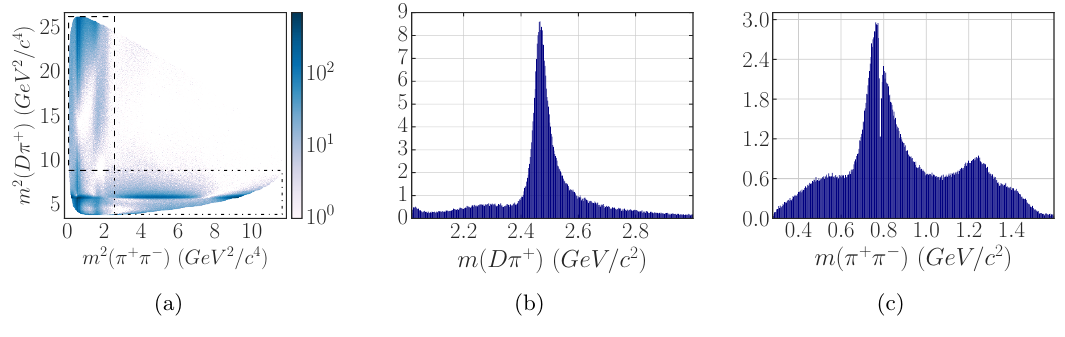
(cid:0) (cid:1) D 0 (cid:25) + (cid:25) (cid:0) decay (a), m D 0 (cid:25) + distribution be- ! D 0 (cid:25) + (cid:25) (cid:0) decay am- !